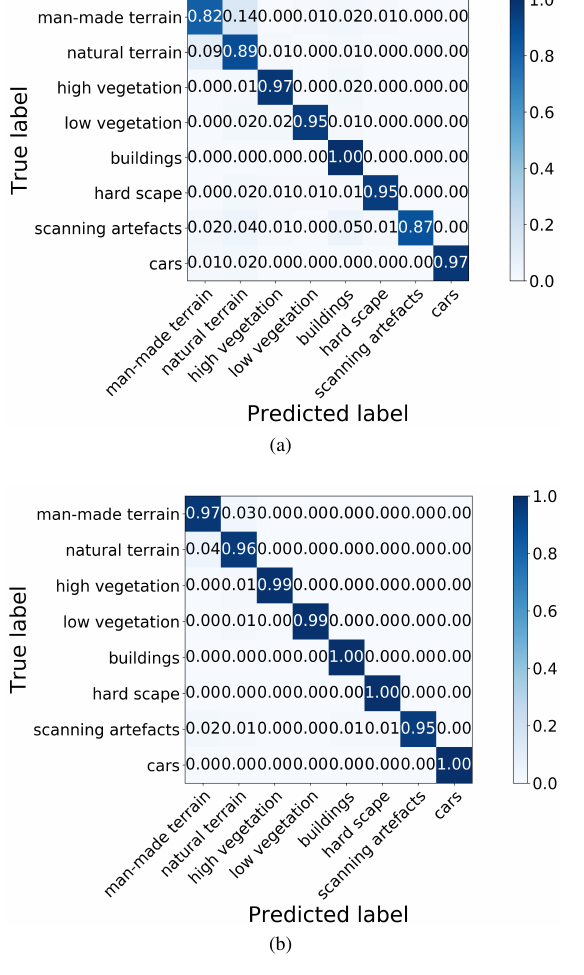
Figure 3. Confusion matrices for a) Semantic3D with no augmentation and b) Semantic3D with weighted